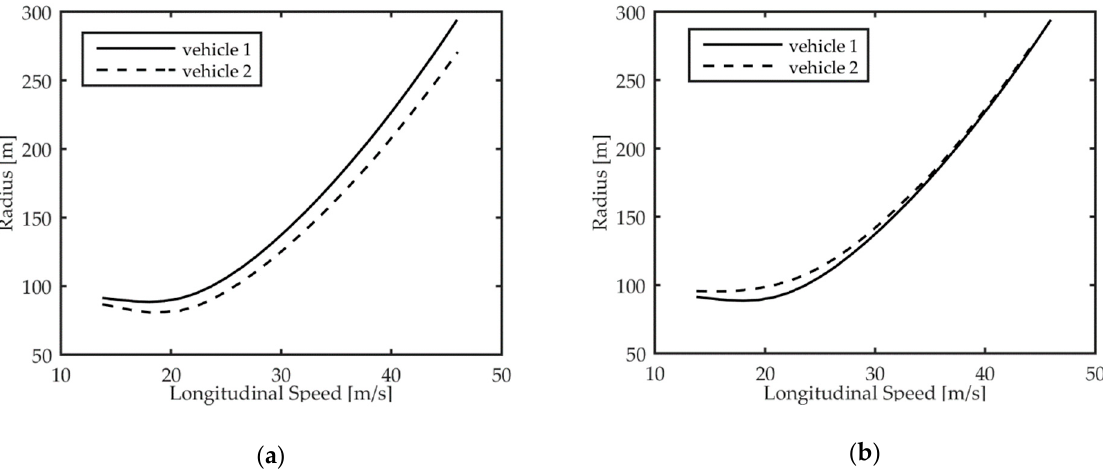
Figure 11. Turning radius as a function of the longitudinal speed for vehicle 2 in both driving mode 1 ( a ) and in driving mode 2 ( b ), as compared to vehicle 1.